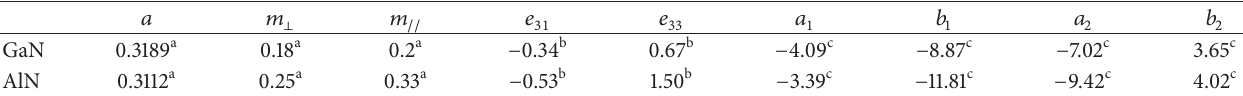
Table 1: Lattice constant 𝑎 (in units of nm), effective mass 𝑚 𝑒 (in units of a free-electron mass 𝑚 0 ), piezoelectric constants 𝑒 31 and 𝑒 33 (in units of C/m 2 ), and deformation potentials 𝑎 1 , 𝑎 2 , 𝑏 1 , and 𝑏 2 (in units of eV).